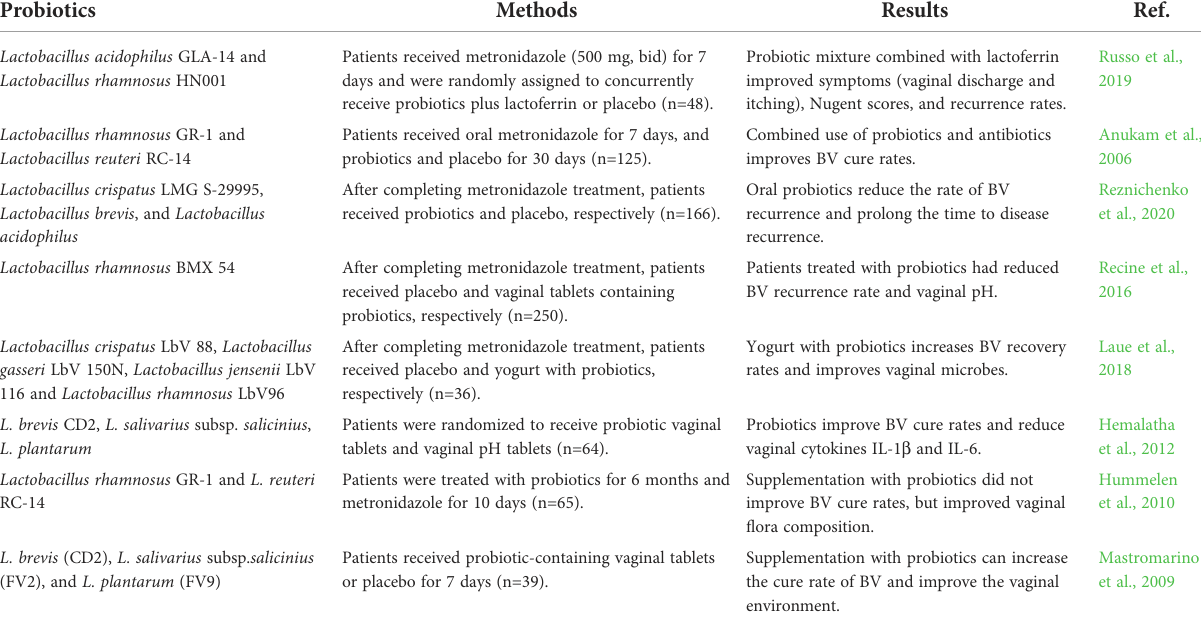
TABLE 3 Summarized the clinical effect of probiotics in the treatment of BV. Probiotics